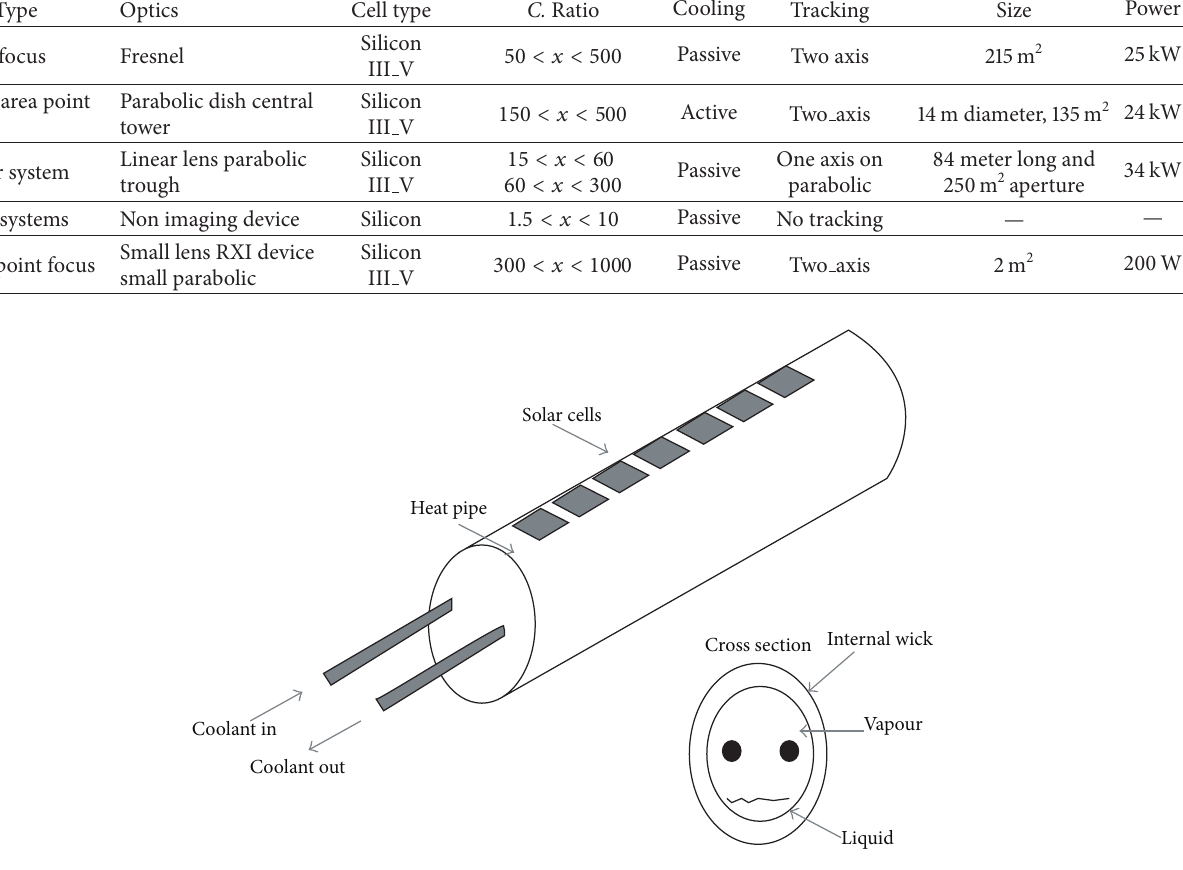
Figure 10: Heat pipe based cooling system